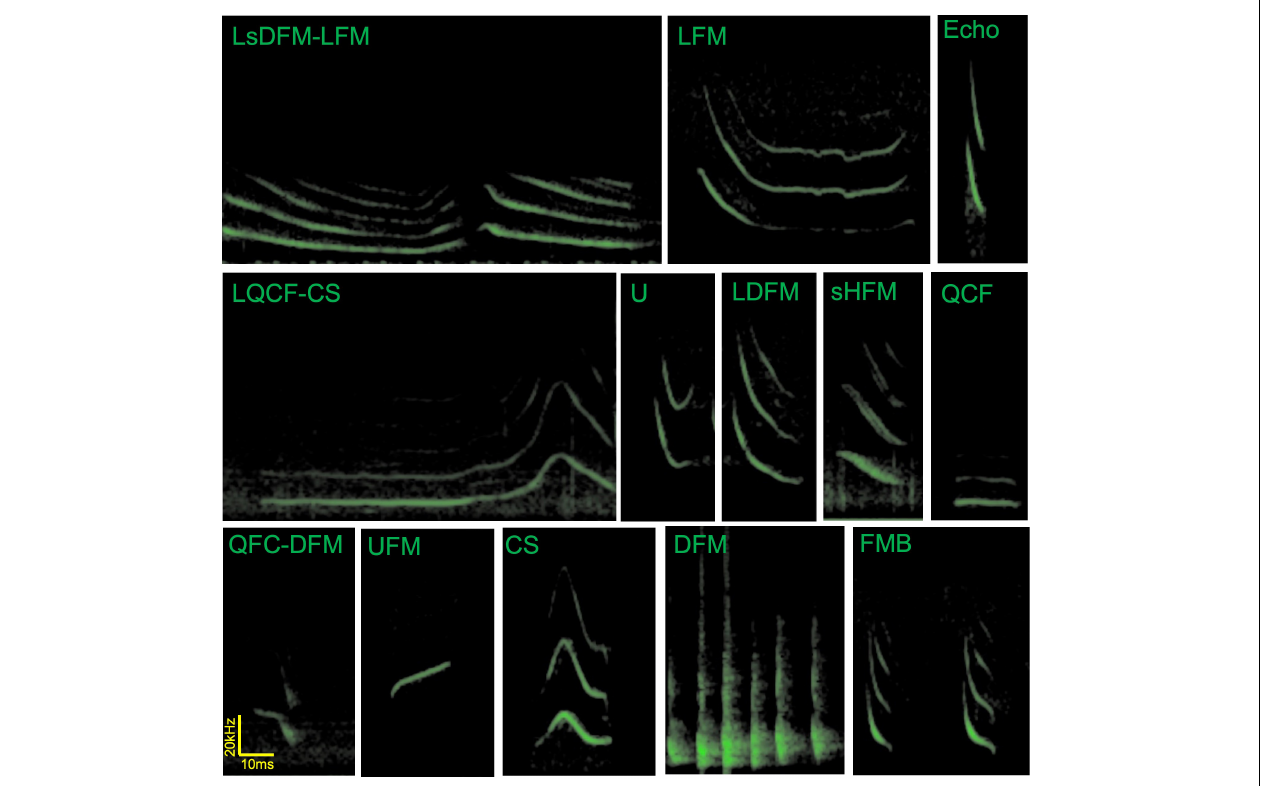
FIGURE 2 | Example spectrograms of vocalizations by Eptesicus fuscus bats in flight and in paired interactions. These calls were recorded by Angeles Salles in Cynthia Moss’s laboratory at Johns Hopkins University. Note that social calls tend to have longer durations than echolocation calls (top right). LsDFM-LFM, long shallow frequency modulation downward—long frequency modulation; LFM, long frequency modulation; Echo, echolocation call; LQCF-CS, long quasi-constant frequency to chevron shape; U, U-shaped call; LDFM, long downward frequency modulation long; sHFM, single humped frequency modulation; QCF, quasi-constant frequency; QFC-DFM, quasi-constant frequency to downward frequency modulation; UFM, upward frequency modulation; CS, chevron shaped call; DFM, downward frequency modulation (here showing a bout containing 6 DFM syllables, these are often emitted as long bouts and may be audible to humans); FMB, frequency modulated bout (FMB refers to each syllable). Though presented separately in this figure, in our experience, U and LDFM calls are often emitted in close succession and at times as a continuum without clear separation of the syllables, similar to LsDFM-FM.